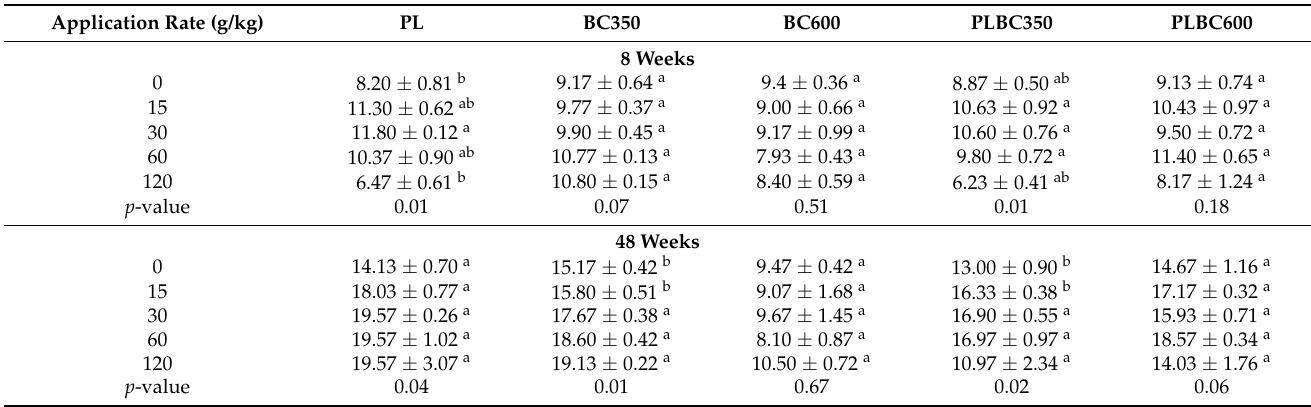
Table 5. Effects of poultry litter and its biochar on Jatropha stem diameter (mm) at different applica- tion rates.